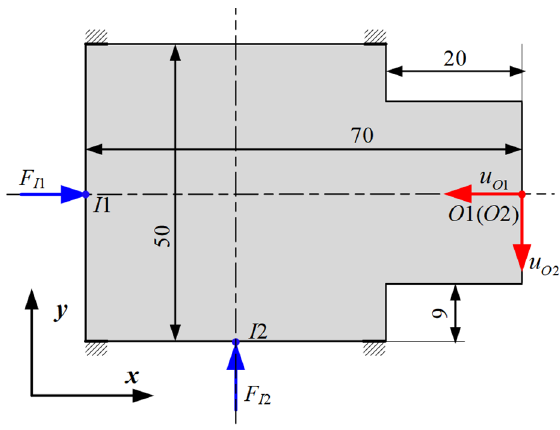
Figure 12. Design domain and boundary conditions of the inverter.